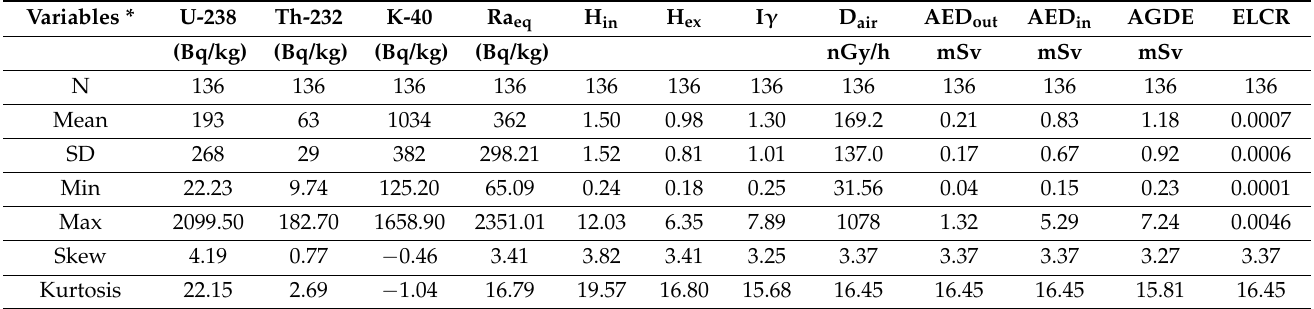
Table 2. Basic statistical summary of muscovite granite rocks, Gabal Qash Amir,